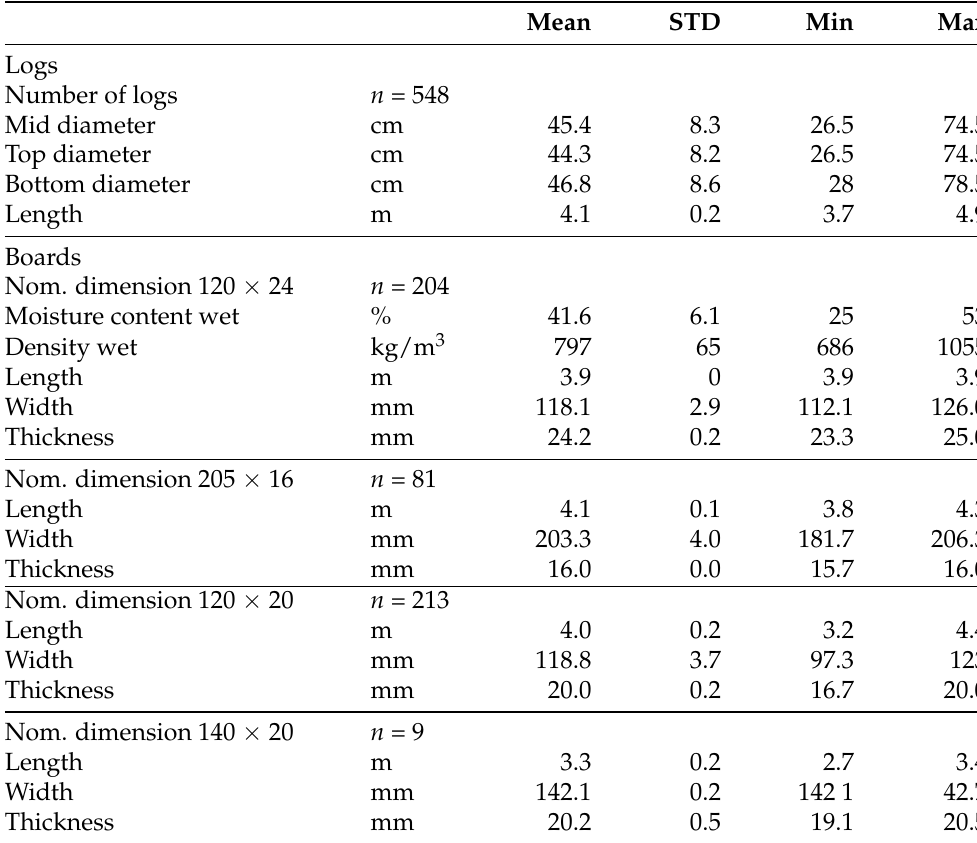
Table 1. Characteristics of logs and